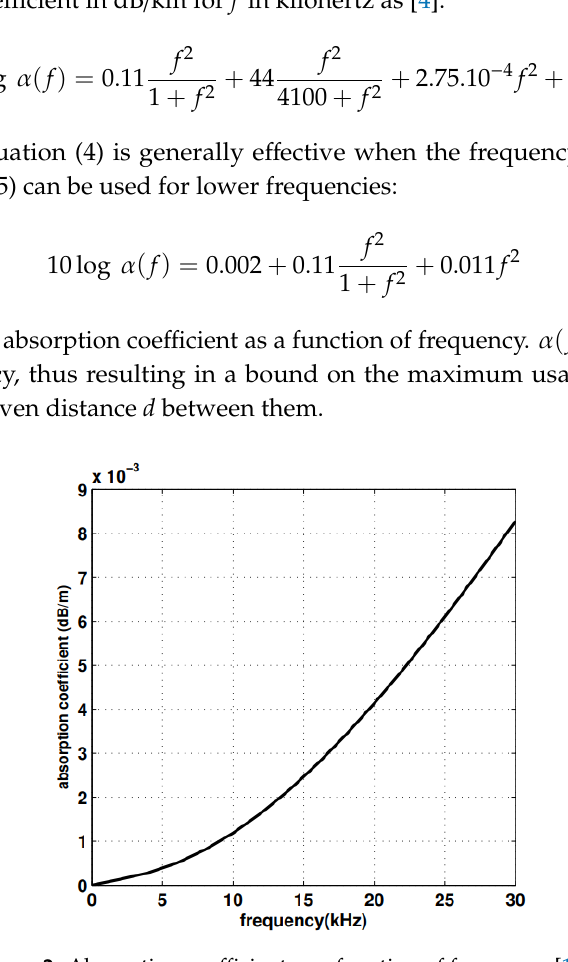
ffi cient as a function of frequency Figure 2. Absorption coefficient as a function of frequency [11] Figure 2. Absorption coe